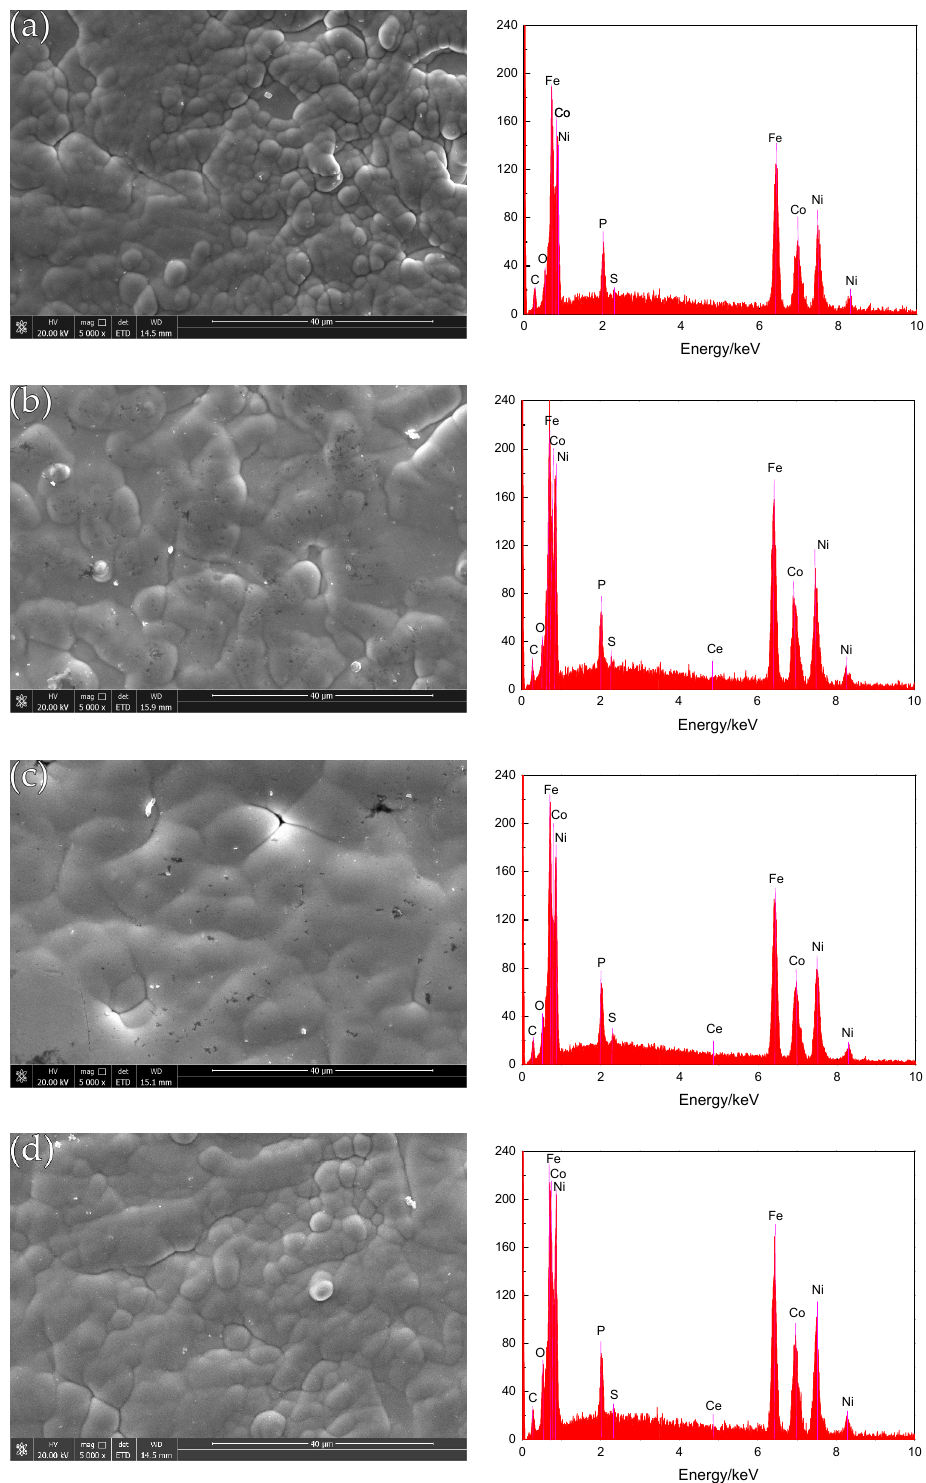
Figure 3. Surface morphology of the coatings before corrosion and EDS spectrum of coatings: ( a ) Ni-Fe-Co-P; ( b ) Ni-Fe-Co-P-0.5g / L CeO 2 ; ( c ) Ni-Fe-Co-P-1g / L CeO 2 ; and ( d ) Ni-Fe-Co-P-1.5g / L CeO 2